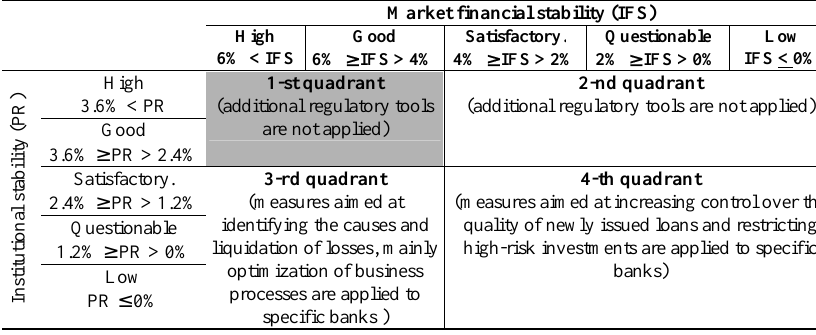
Table 6. Criteria for selecting regulatory tools at the macro